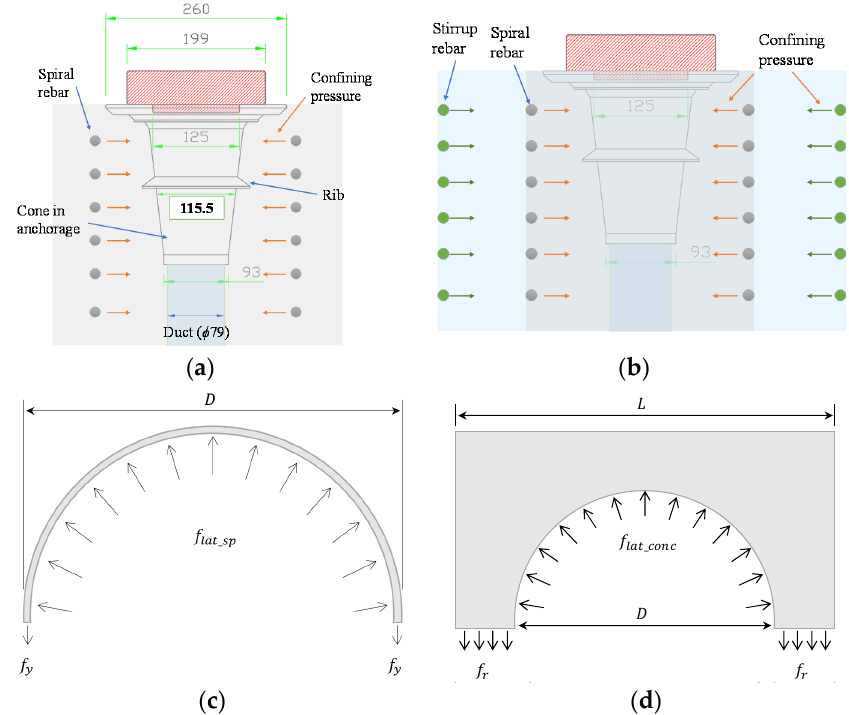
Figure 2. Lateral confinement: ( a ) anchorage device, duct, and confinement by rebar; ( b ) confinement by spiral and stirrup rebar; ( c ) confinement by spiral rebar; ( d ) confinement by the surrounding concrete.